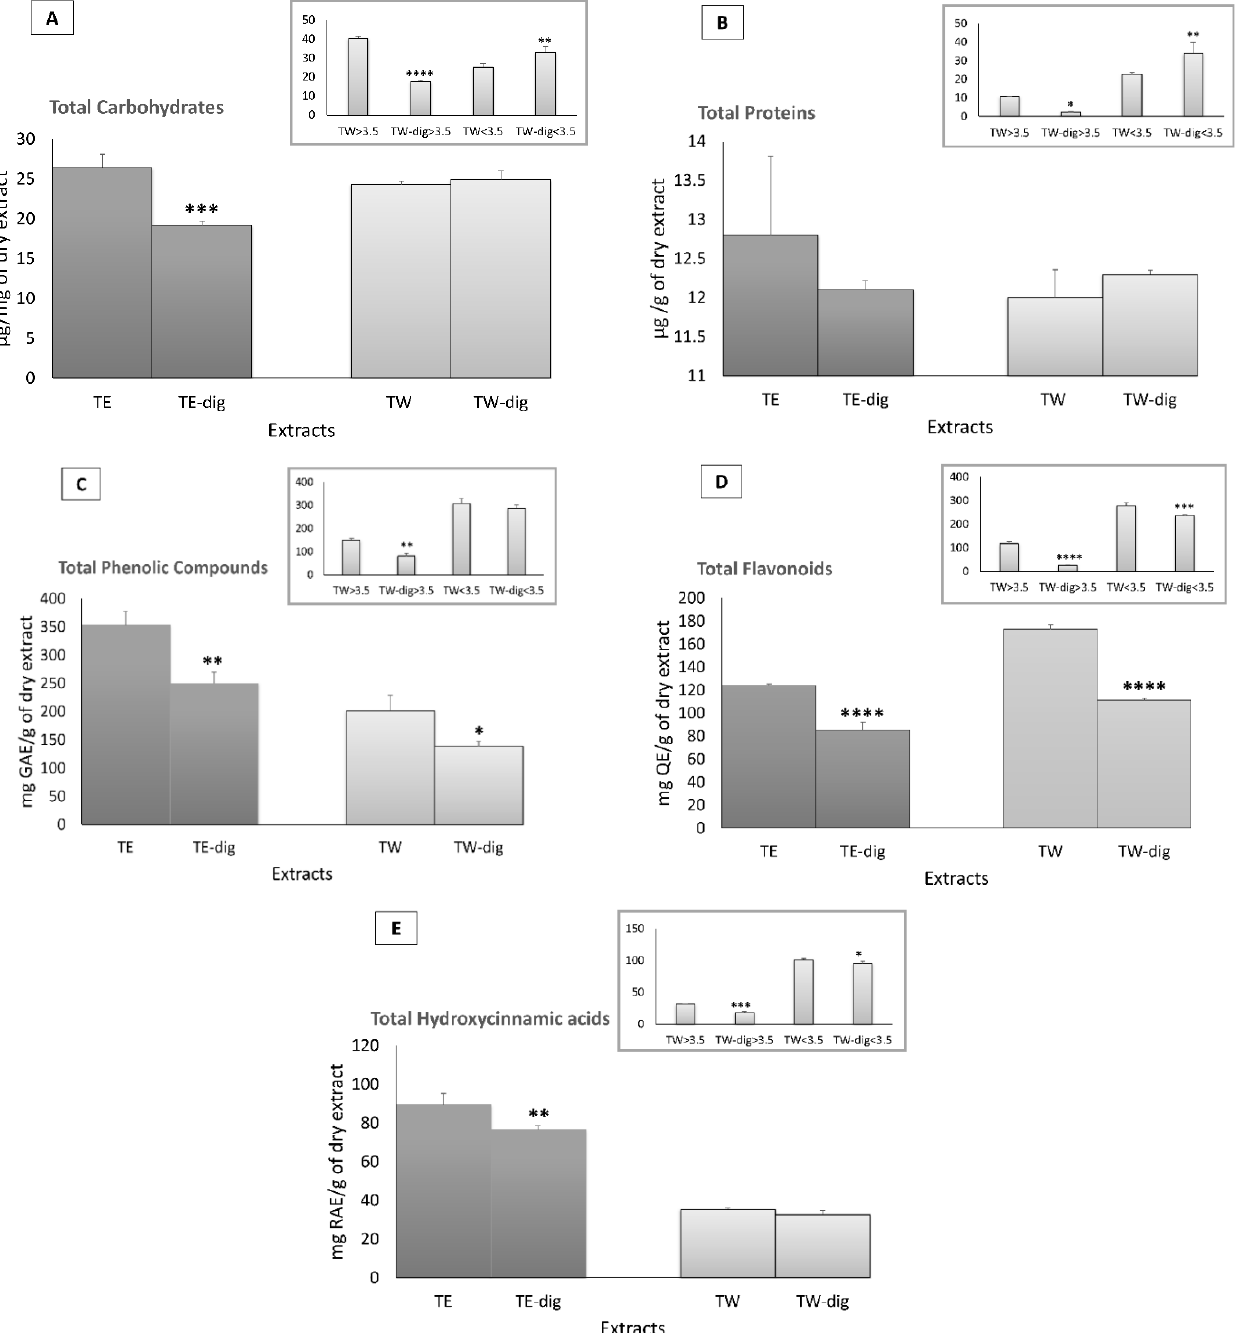
Figure 2. Quantification of total carbohydrate contents (TCC) ( A ), total protein content (TPrC) ( B ), total phenol content (TPC) ( C ), total flavonoid content (TFC) ( D ), and total hydroxycinnamic acid content (THAC) ( E ) of TW and TE, and dialyzed fractions before and after simulated in vitro digestion. All the contents were quantified spectrophotometrically and expressed as µg/mg of the dry extract, µg/g of dry extract, mg of gallic acid equivalent per g of dry powder extract (mg GAE/g dry extract), mg of quercetin equivalent per g of dry powder extract (mg QE/g dry extract), and mg of rosmarinic acid equivalents (RAE) per gram of dried weight extract (mg of RAE/g extract), respectively. Samples were measured in triplicate, and significant differences between digested and undigested extracts are denoted by symbols: * p < 0.05, ** p < 0.01, *** p < 0.001, and **** p < 0.0001.